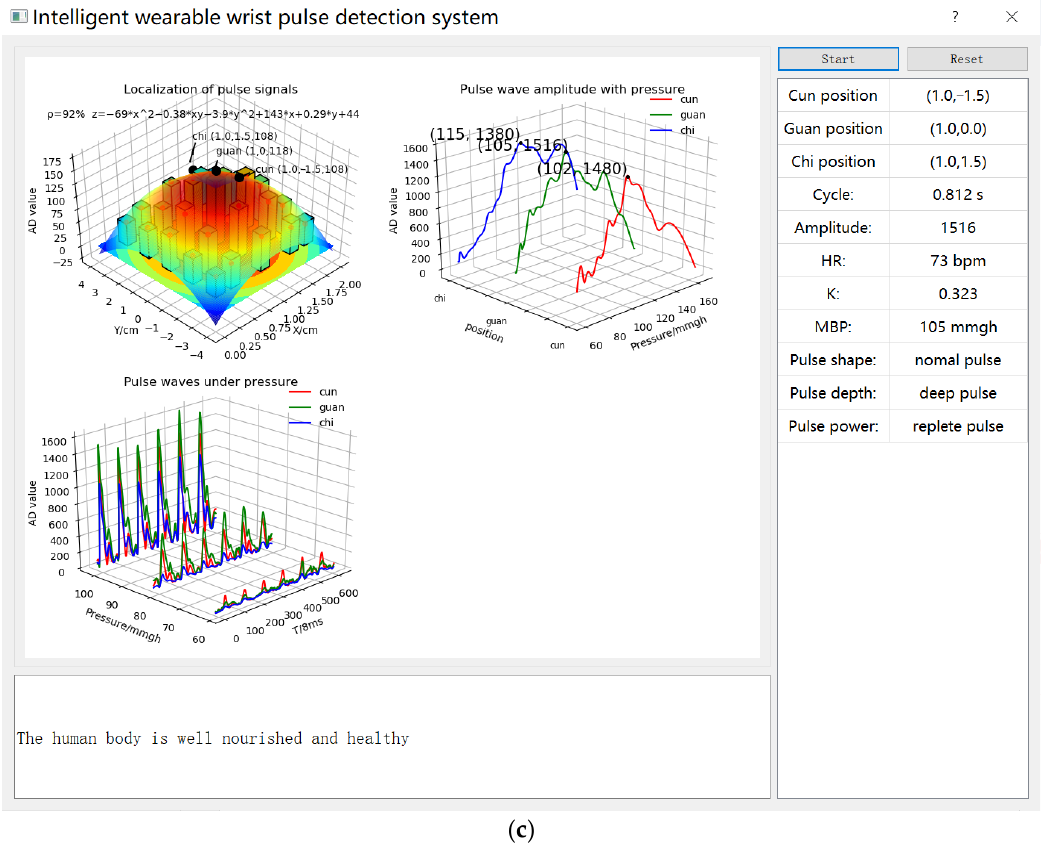
Figure 3. System acquisition process: ( a ) working principle of the system; ( b ) flow chart; and ( c ) system interface.